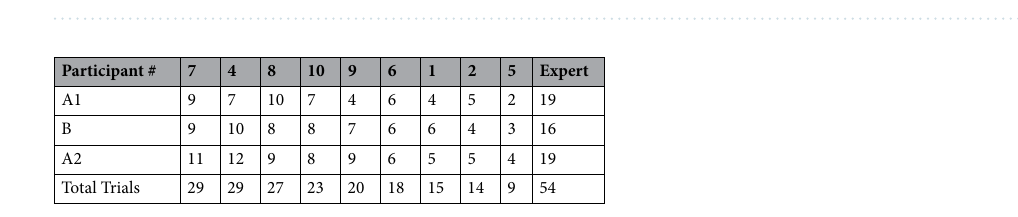
Figure 3. A typical raw and normalized time series of hoverboard centre position in x ( A ) and y ( F ) directions; ( B ) The hip, ( C ) knee, and ( D ) ankle angles; ( E ) the hoveboard plate orientation; ( G ) Bicep Femoris, ( H ) Gastrocnemius Medial Head, ( I ) Rectus Femoris, and ( J ) Tibialis Anterior muscle activation of the right leg in condition B for an average participant (#9). The blue area denotes the forward motion intervals. Value of the normalized signals are reported on the right axis of each figure.